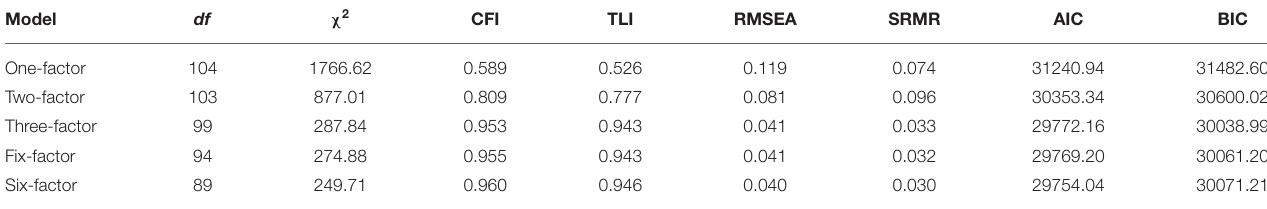
TABLE 7 | Model fit indices of models with different number of factors. Model df